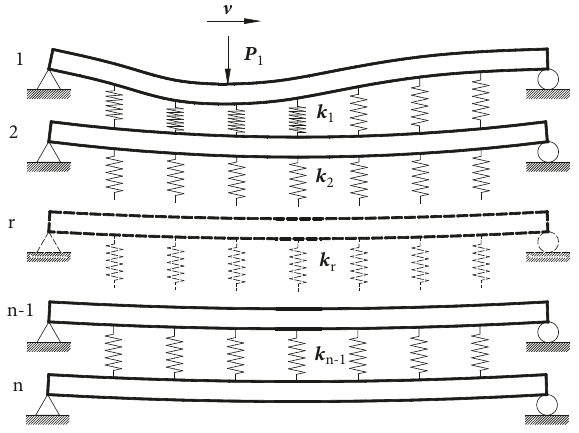
Figure 1: Model of a multiple simply supported beam